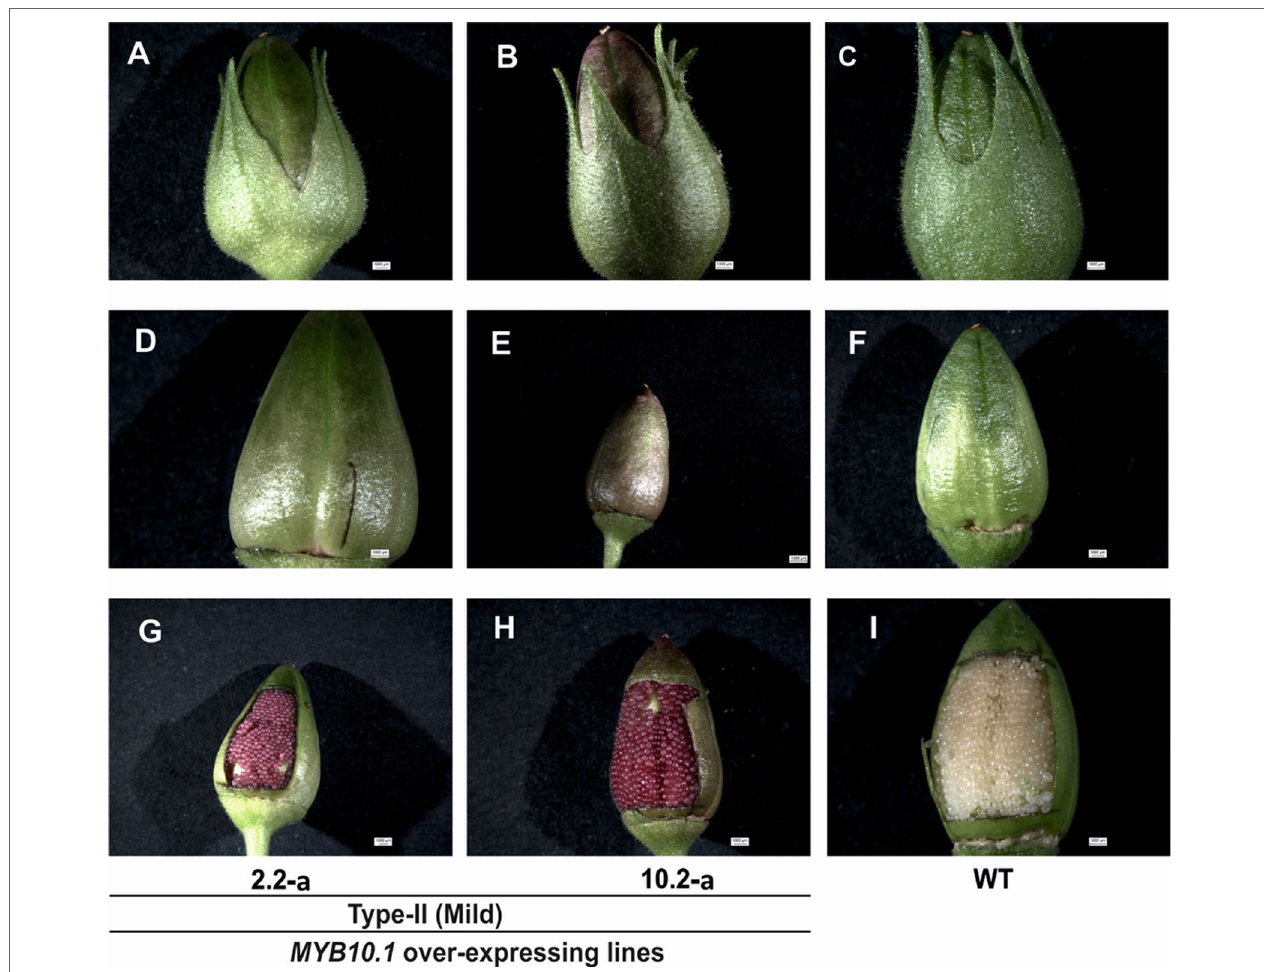
FIGURE 8 | The phenotypes of the capsule and developing seed coat produced by individuals of the T 1 generation from selfed type II plants, compared to WT. The images (A – C) , (D – F) , and (G – I) indicate capsules with calyx, capsules without calyx, and open capsules showing developing seeds,